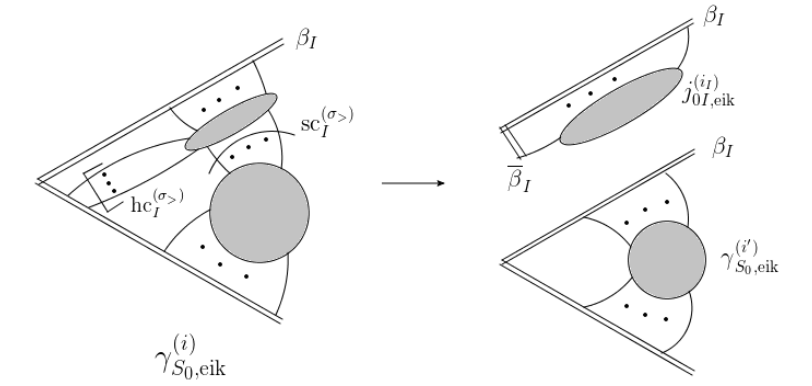
0 ) ( (cid:12) 1 ; : : : ; (cid:12) N ) and j ( i I ) S 0 ; eik 0 ) and j ( i I ) are disjoint due to the factorization from the approximations S 0 ; eik 0 I; eik